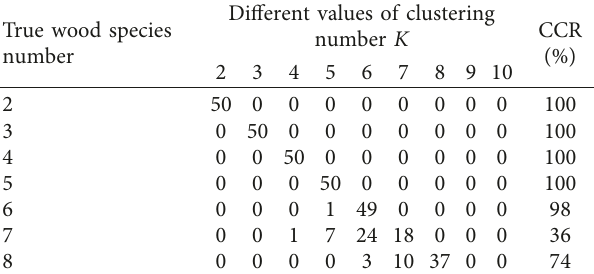
Table 5: CFSFDP clustering analysis with DB i and δ i .